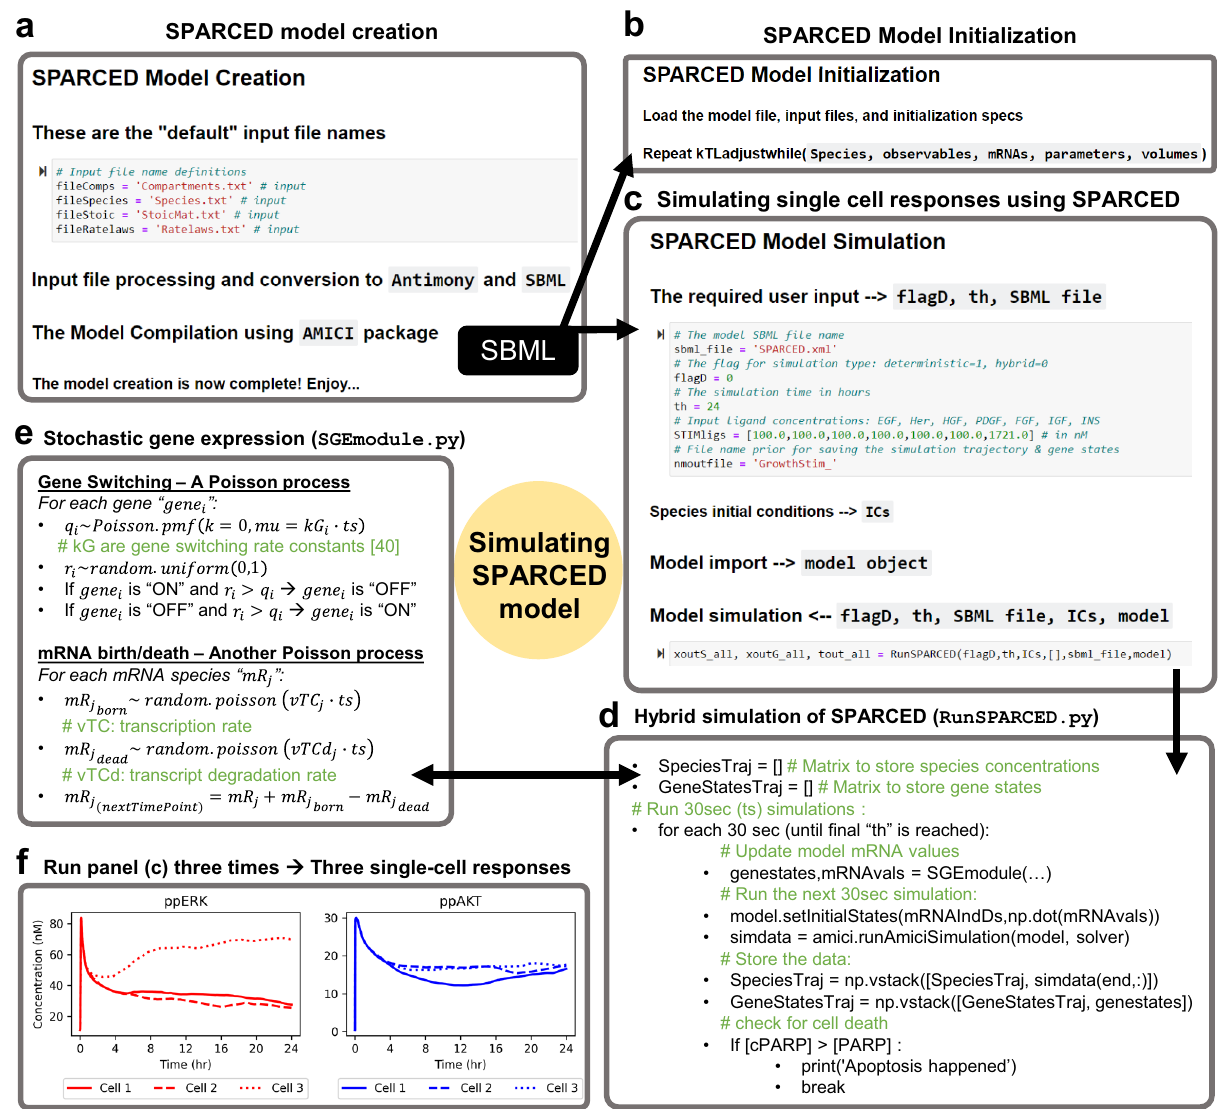
Fig. 2 SPARCED-jupyter enables single-cell response simulations using Jupyter notebooks. a The model creation notebook processes the input fi les and converts them into the model SMBL fi le, which is compiled for simulations using the AMICI python package. b When a model is generated for a